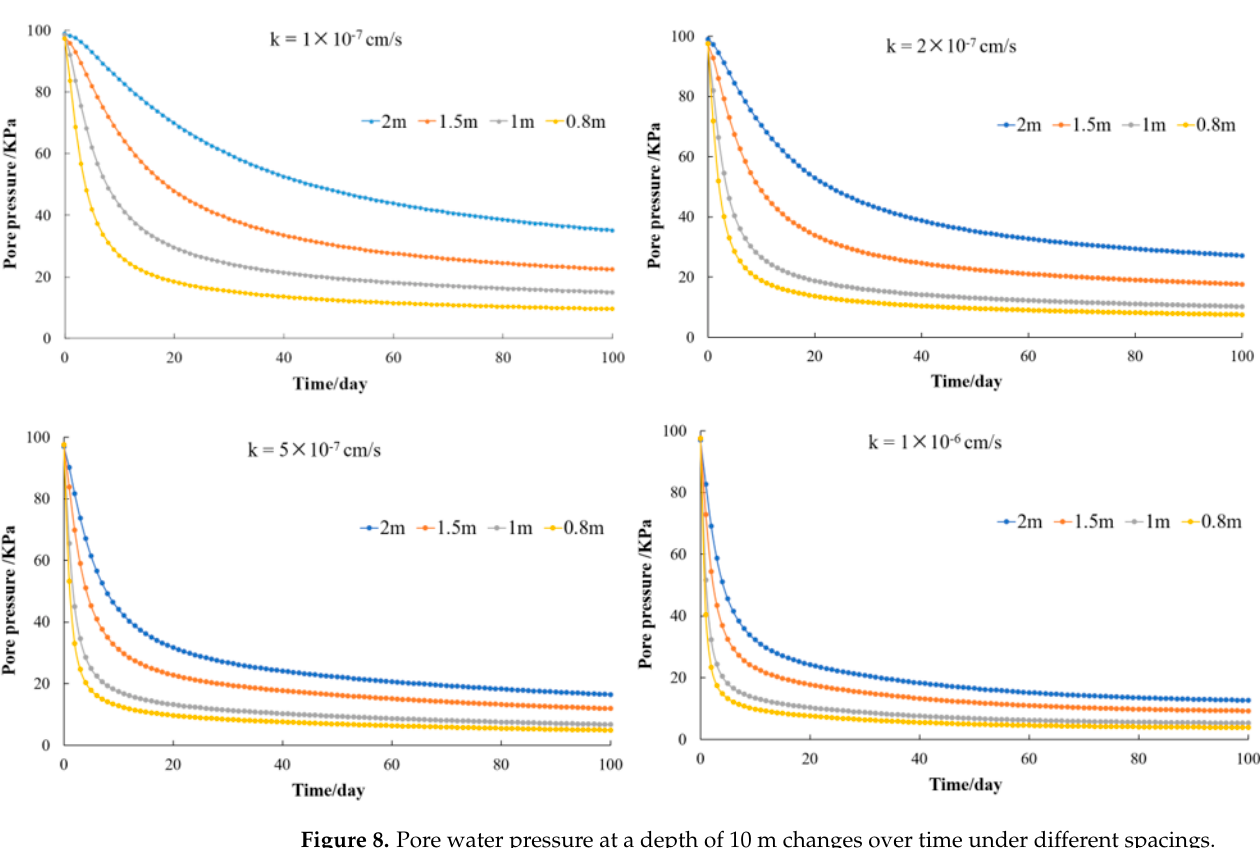
Figure 8. Pore water pressure at a depth of 10 m changes over time under different spacings.